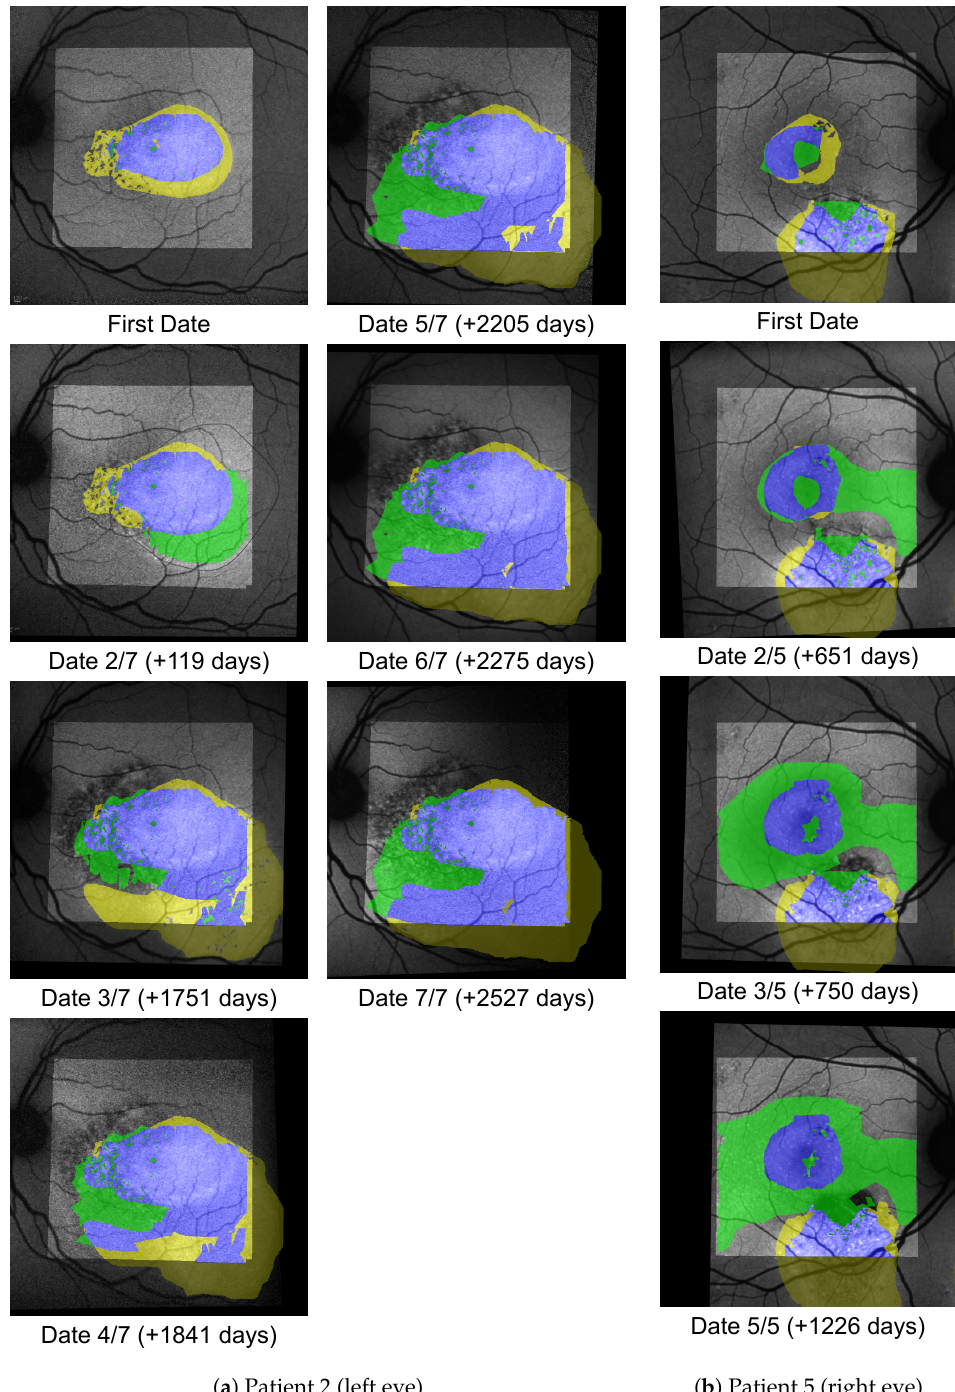
Figure A3. Shown here are progression from the excluded group, where no chronology can be